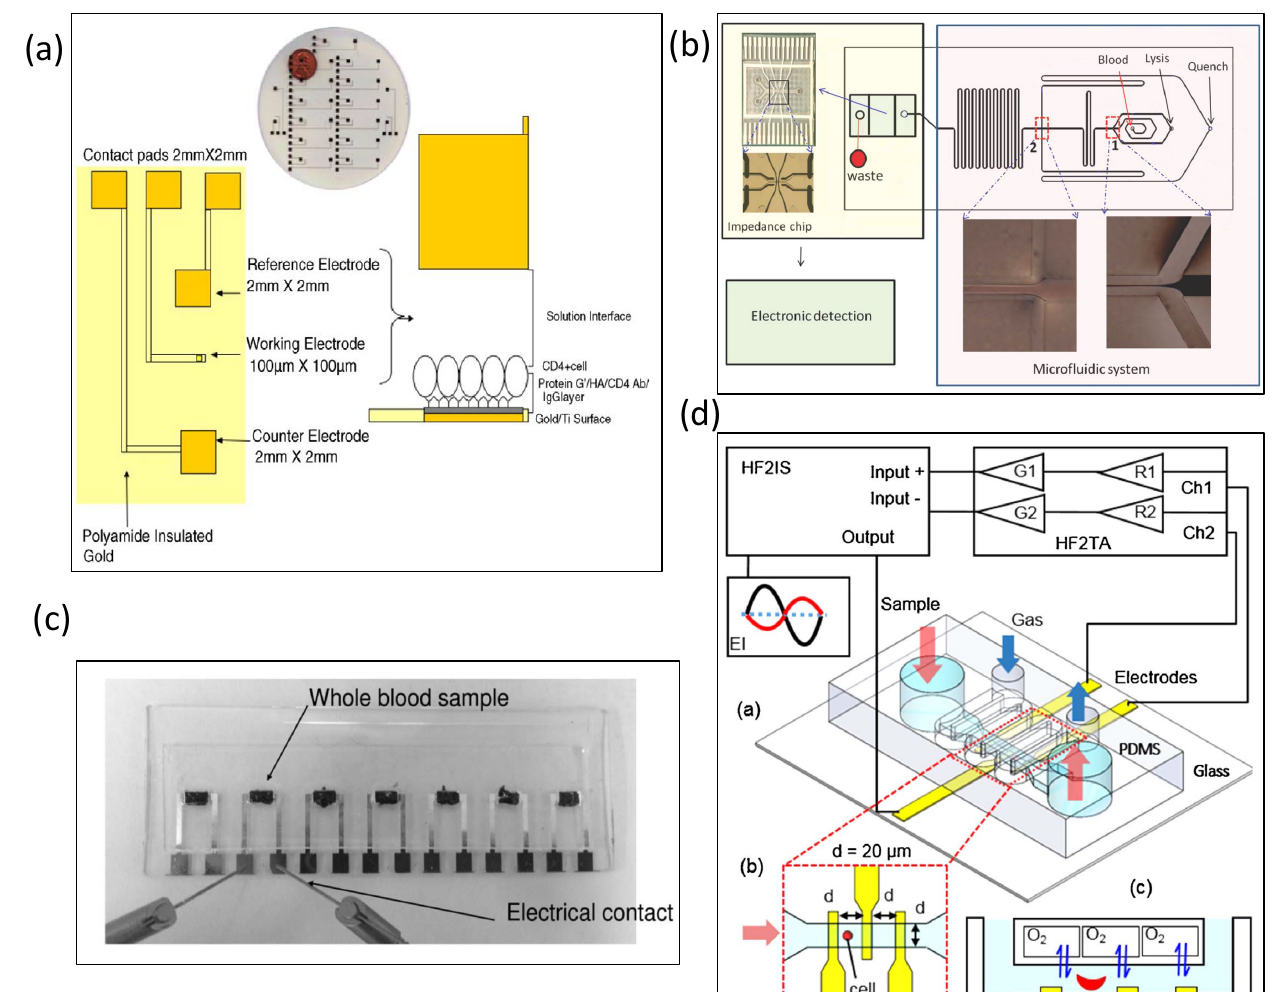
Figure 5. Glass-based impedance biosensors for detecting blood. ( a ) Three microelectrodes were used to sense the impedance of human CD4(+) cells in blood. Reproduced with permission from [61]. Copyright Biosensors and Bioelectronics 2005. ( b ) A microfluidic impedance cytometer was for red blood cell lysis. Reproduced with permission from [64]. Copyright Analytical Chemistry 2011. ( c ) A microfluidic chip was designed to detect electrical impedance for monitoring the blood coag- ulation process. Reproduced with permission from [65]. Copyright PLoS ONE 2013. ( d ) An electrical impedance microflow cytometer with controlled oxygen flow for the analysis of sickle blood cells.